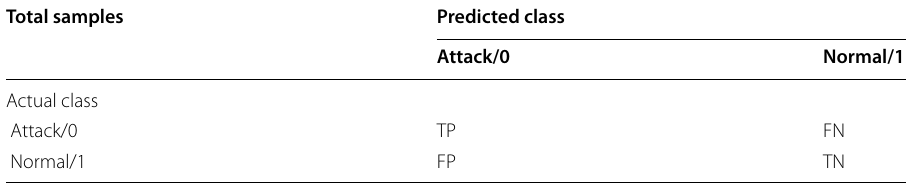
Table 3 Data distribution of NSL‑KDD